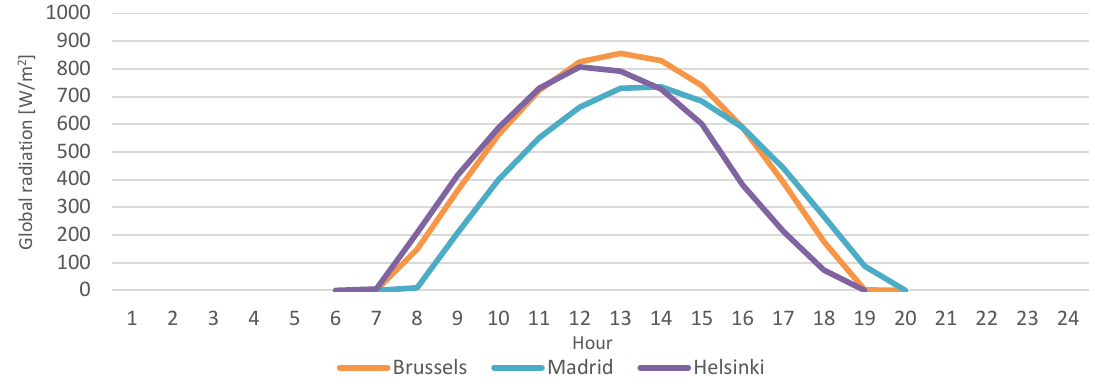
Fig. 5: Solar radiation for vertical glazing on southern façade in